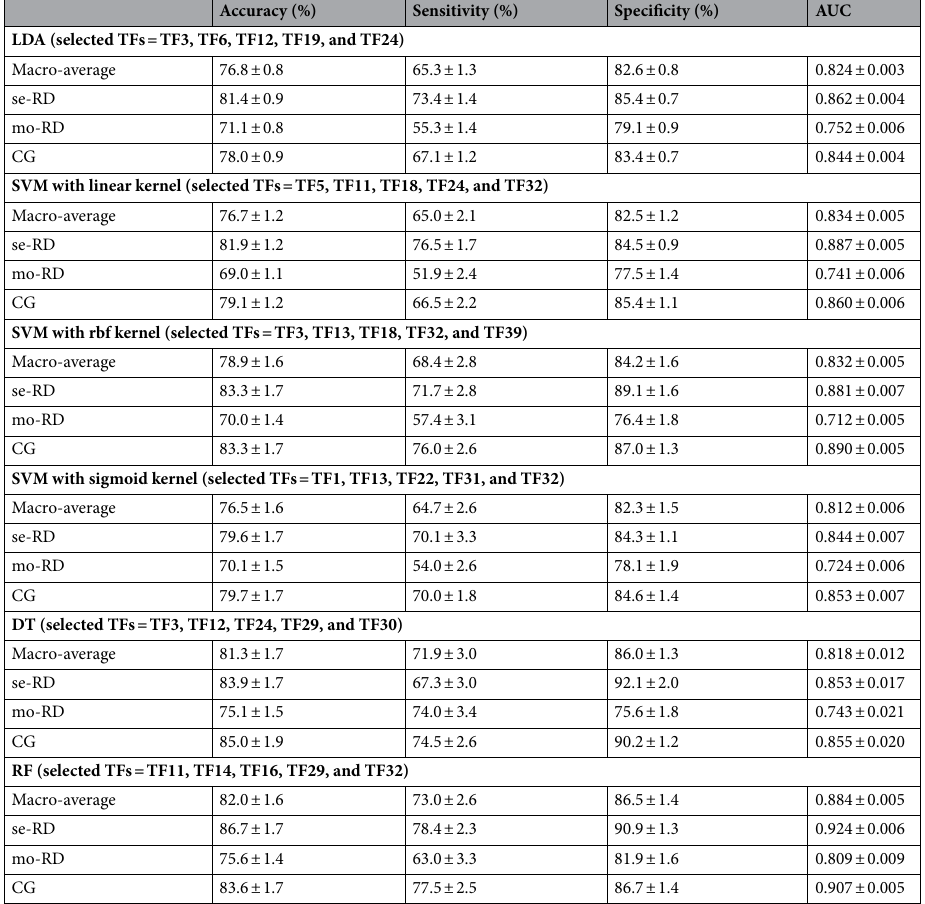
Table 5. Performance of each classification attempt in discriminating between the three groups in T1-weighted water-only imaging (T1WI WO). TF texture feature, DT decision tree, LDA linear discriminant analysis, SVM support vector machine, RF random forest classifier, AUC area under the curve, se-RD severe renal dysfunction (estimated glomerular filtration rate [eGFR] < 30 mL/min/1.73 m 2 , i.e., CKD stage G4–5), mo-RD moderate renal dysfunction (30 ≤ eGFR < 60 mL/min/1.73 m 2 , i.e., CKD stage G3a/3b), CG control group (eGFR ≥ 60 mL/min/1.73 m 2 , i.e., CKD stage G1–2). Feature name codes are as follows: TF1 = 10th percentile, TF3 = energy, TF5 = interquartile range, TF6 = mean absolute deviation, TF11 = total energy, TF12 = uniformity, TF13 = difference average, TF14 = difference entropy, TF16 = idm, TF18 = joint energy, TF19 = joint entropy, TF22 = dependence non uniformity, TF24 = dependence variance, TF29 = gray level non uniformity normalized, TF30 = long run emphasis, TF31 = run entropy, TF32 = run length non uniformity, TF39 = small area emphasis. The data are expressed as means ± standard